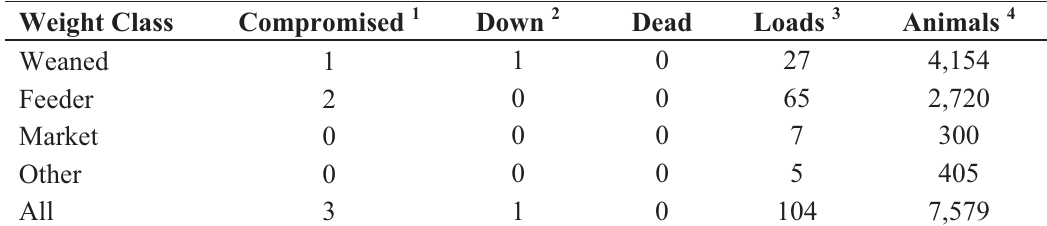
Table 7. Number of compromised, down, and dead cattle observed for loads stopping for feed, water and rest in Thunder Bay, ON, based on their production classes. No load contained more than one compromised, down, or dead